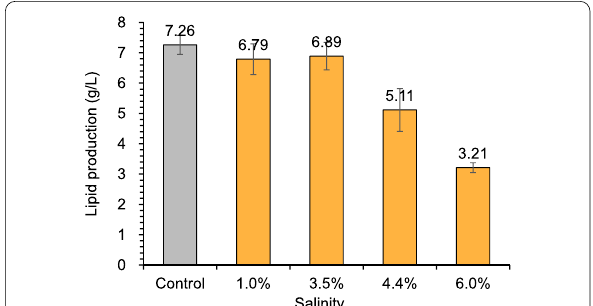
Fig. 2 Lipid production of T. cutaneum ACCC 20271 at different salinities. The lipid production was measured after 120 h in a 3-L bioreactor with a work volume of 800 mL, 10% (v/v) inoculum size, 30 °C, 450 rpm, pH 5.0 by 5 M NaOH and 4 M HCl, and the aeration at 1.0 vvm. Fresh water was used as the control. All experiments were